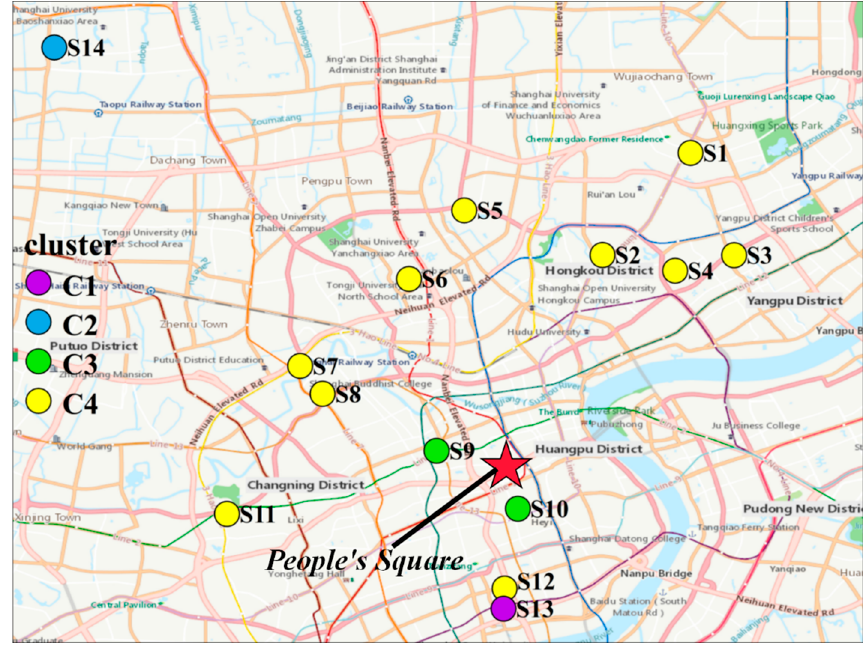
Figure 8. The spatial distribution of the 14 communities with their cluster characteristics.